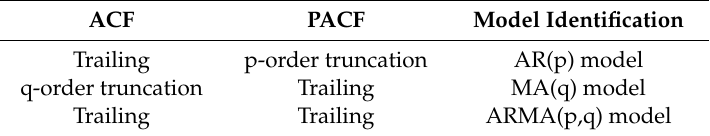
Table 6. The identification of autoregressive moving average (ARMA) method. ACF